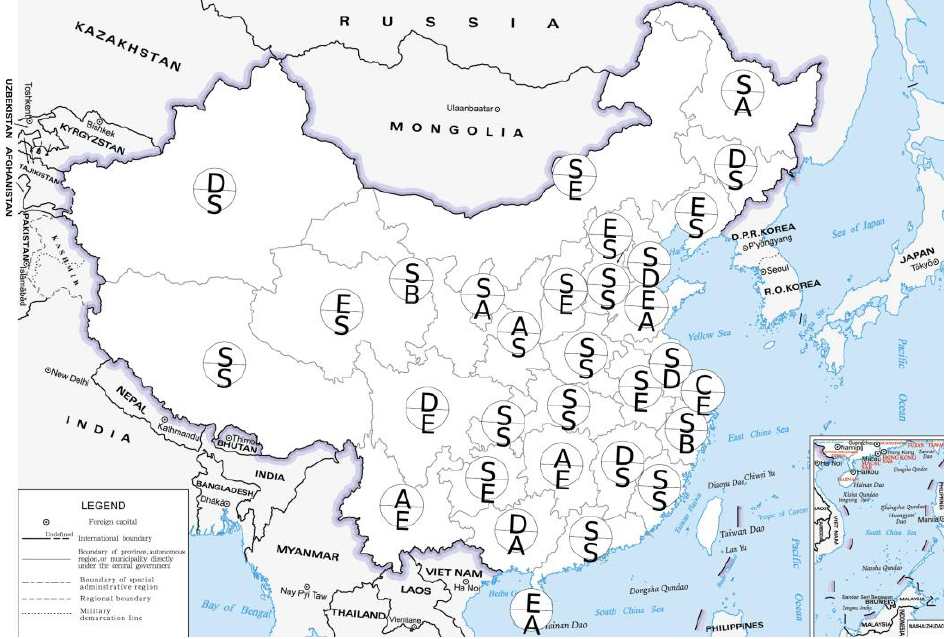
Figure 4. Ranks of industrial pollution effectiveness. (Note: the map is made based on the GS (2019) 1679, available online: http://bzdt.ch.mnr.gov.cn, accessed on 17 February 2023).